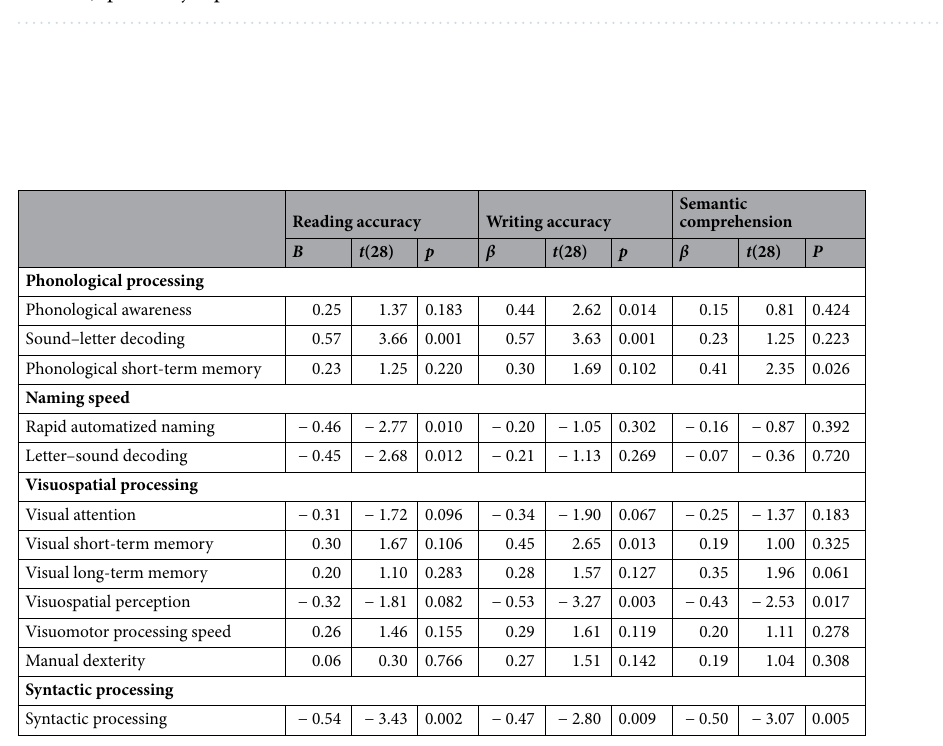
Table 2. Scores on language and cognitive measures in participants. Note: n = 30. SD standard deviation, Kanken Japan Kanji Aptitude Test.